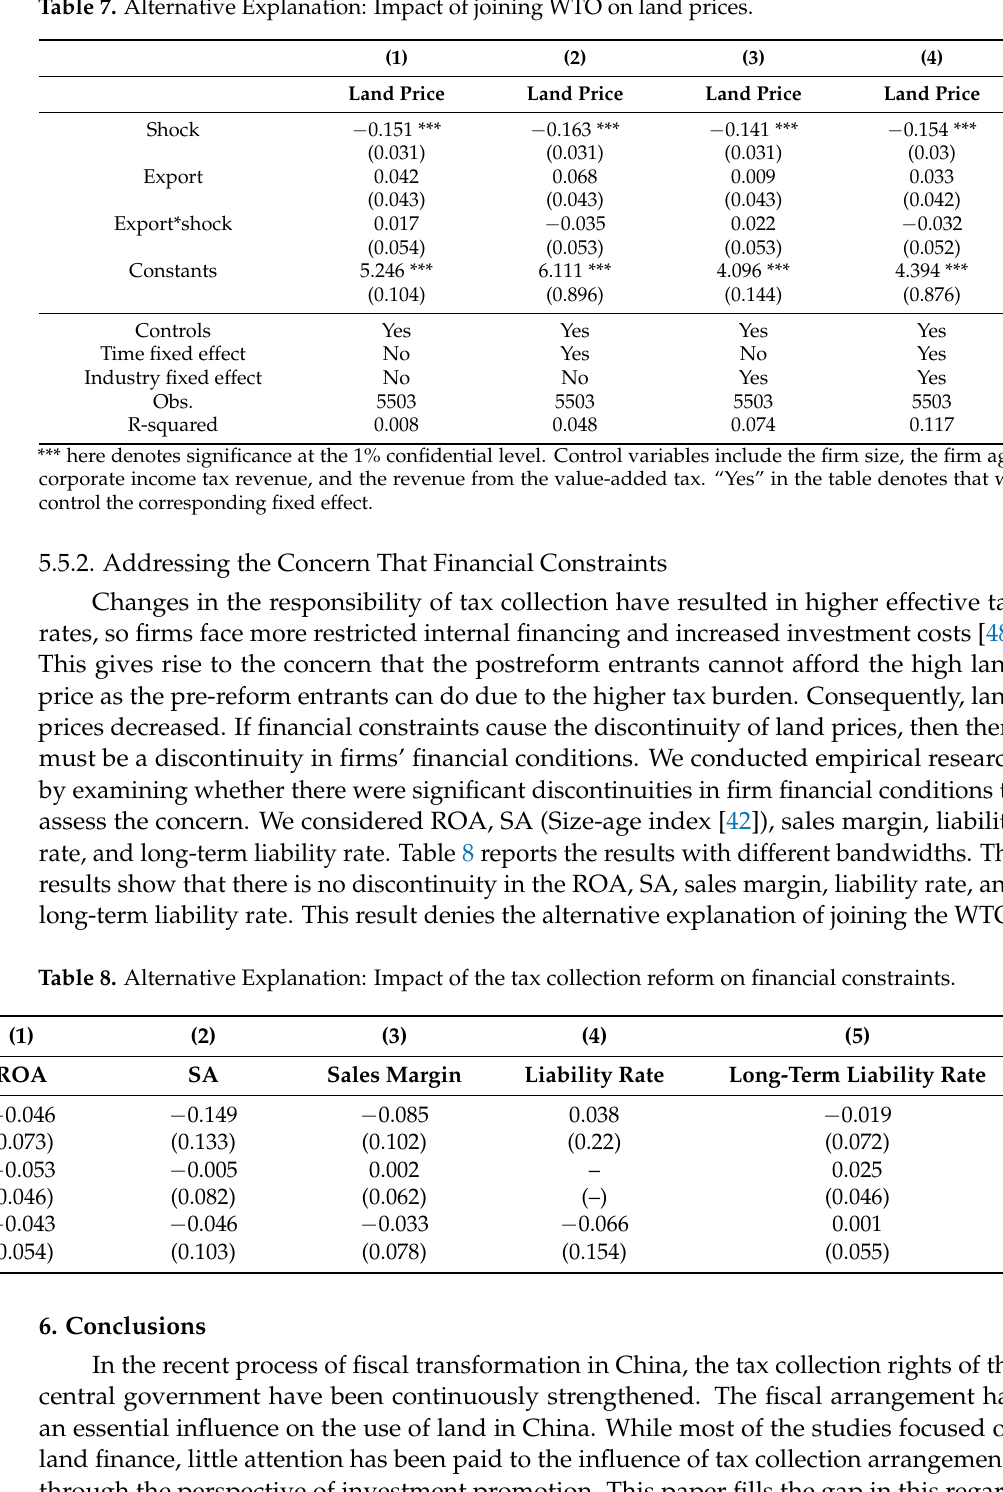
Table 7. Alternative Explanation: Impact of joining WTO on land prices.